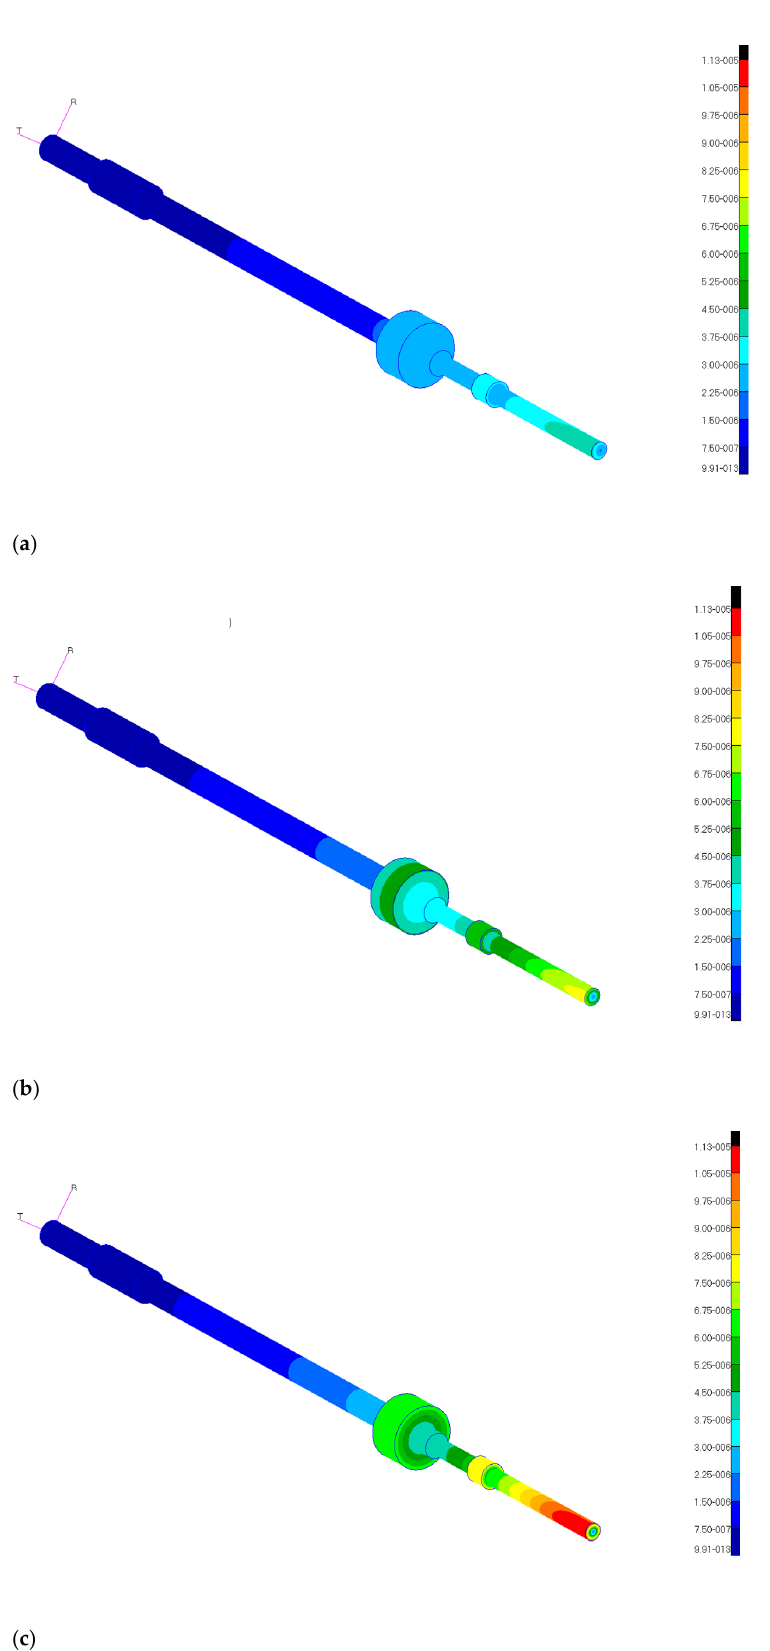
Figure 16. Shaft displacement. ( a ) displacement at 145,000 rpm, ( b ) displacement at 180,000 rpm ( c ) displacement at 210,000 rpm.